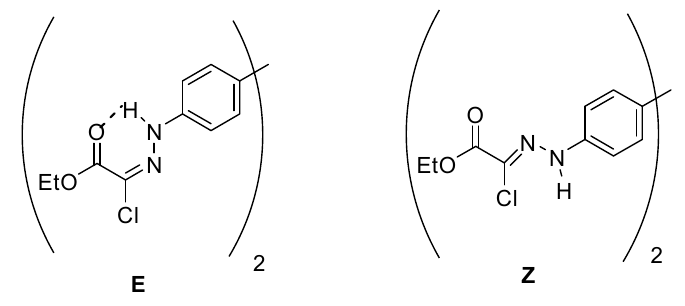
Figure 2. E and Z geometric